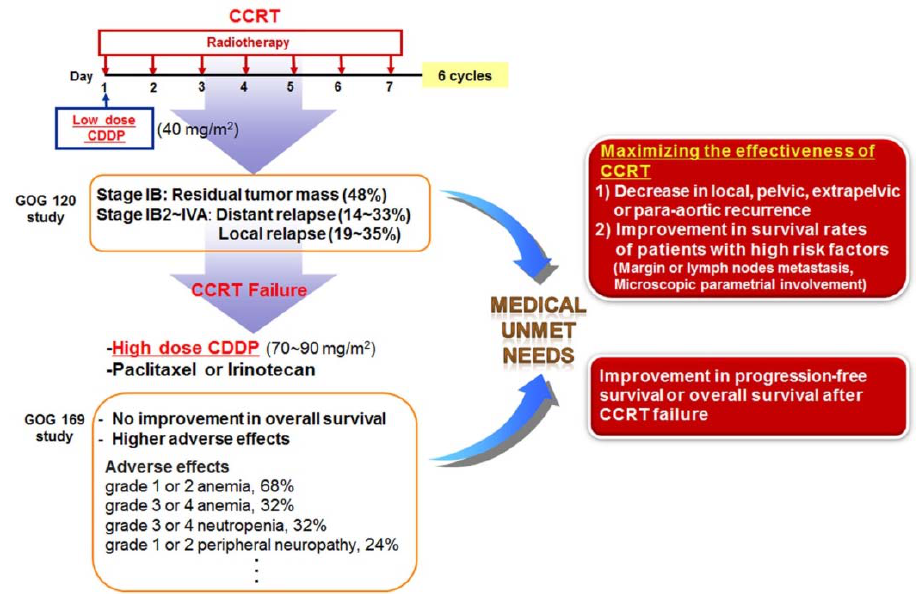
Figure 3. Unmet medical needs of cervical cancer. It is important to maximize the effectiveness of CCRT in order to decrease recurrence and improve the survival